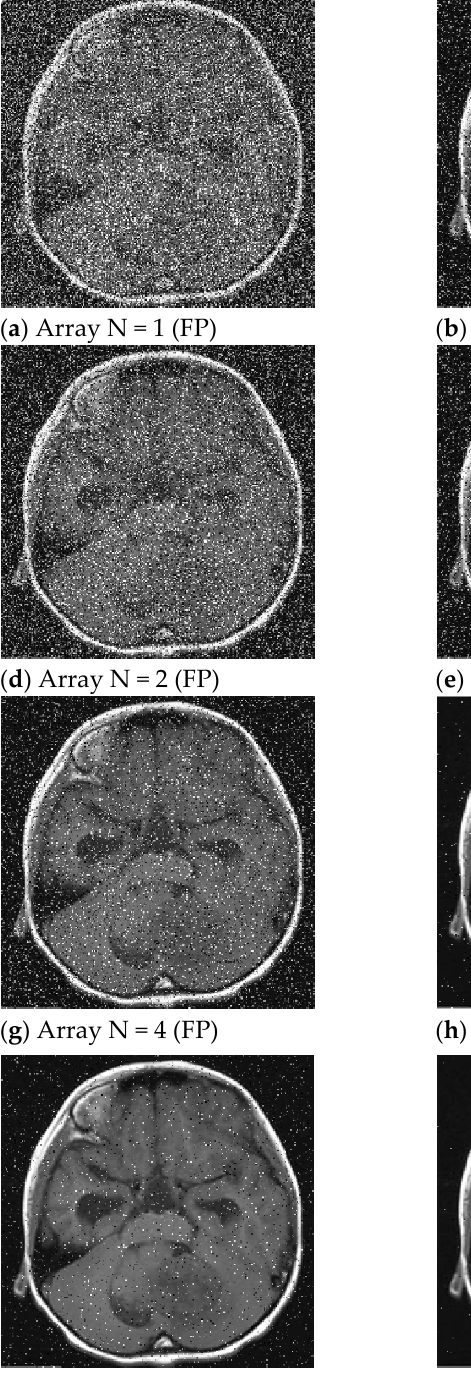
Table 6. MRI image PSNR under different array saturation model methods (dB). Array Unit N = 1